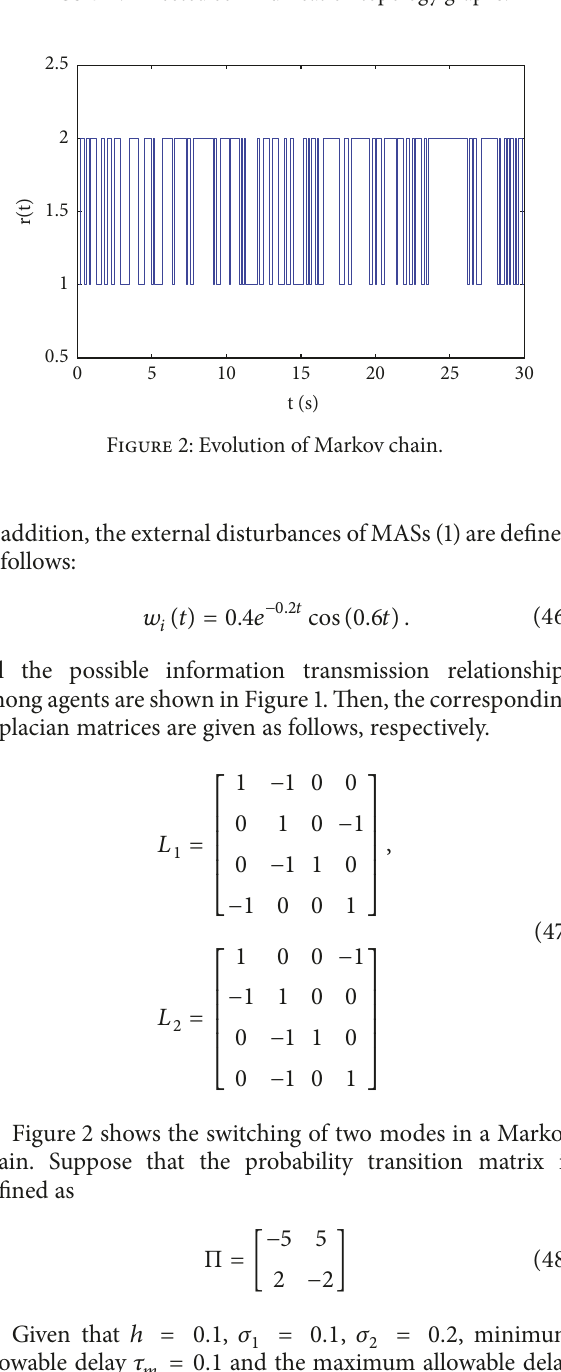
Figure 1: Directed communication topology graphs.